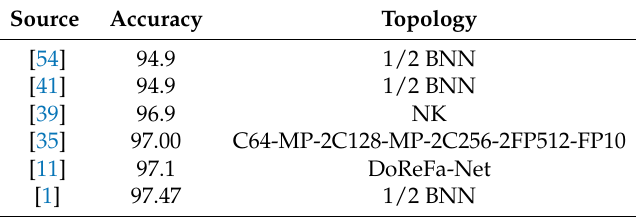
Table 7. BNN accuracies on the SVHN dataset.